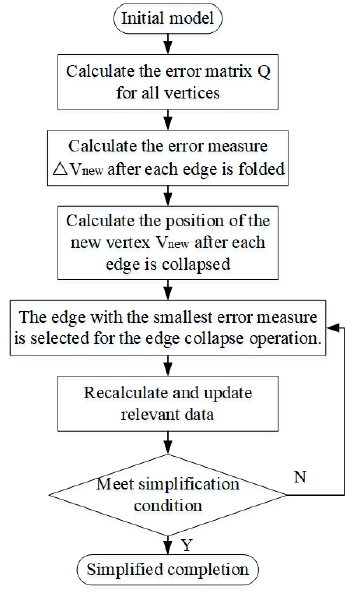
Fig. 5. The flow chart of the QEM algorithm The flow of the QEM algorithm is shown in Fig. 5, and the iteration stops when the simplified condition is met.